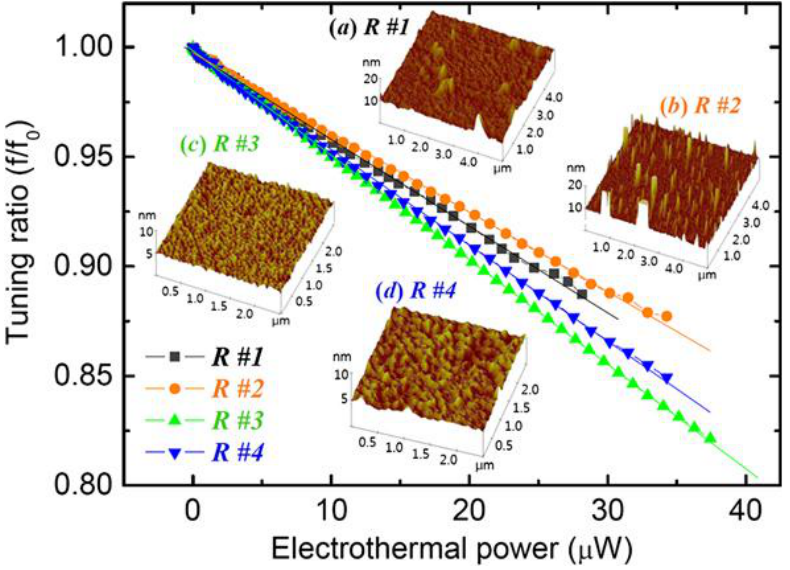
Figure 20. Frequency tuning performance as a function of surface roughness of the nanobeam resonator [275]. The average roughness of the samples ( a ) R#1: 11.2nm, ( b ) R#2: 28.8 nm, ( c ) R#3: 0.9nm, and ( d ) R#4: 2.4nm, observed in AFM image of surface morphology. Reused with permission from